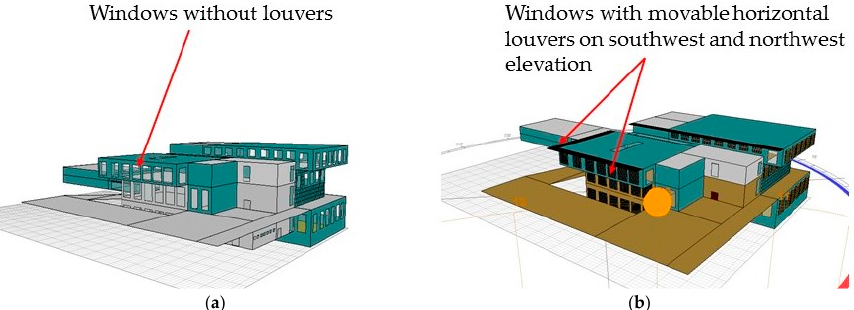
Figure 4. Software models for monthly load/discomfort calculations. ( a ) Model (ii) with proposed